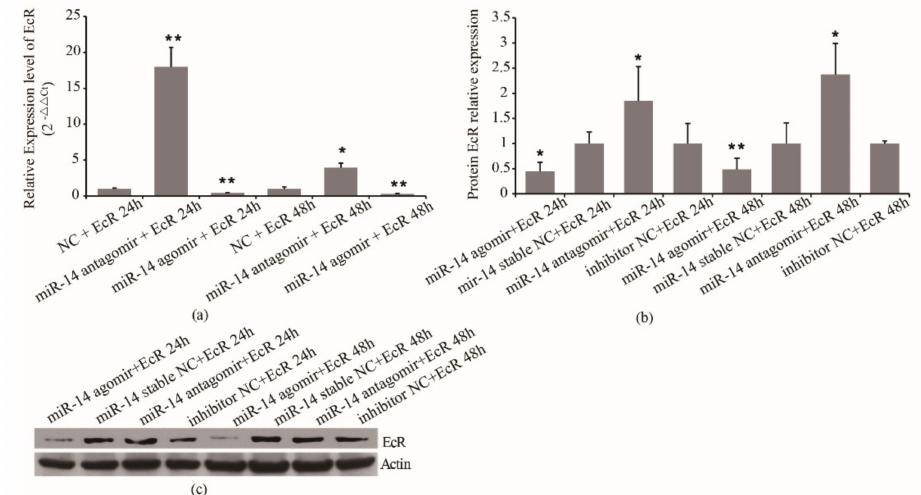
Figure 5. Effect of miR-14 on mRNA and protein level of EcR. ( a ) Effect of miR-14 on mRNA level of EcR. ( b ) Western blot result. ( c ) Effect of miR-14 on protein level of EcR at 24 h and 48 h after treatment. * denoting p < 0.05, ** denoting p < 0.01. Data are from three replicates. β -actin was used as the reference